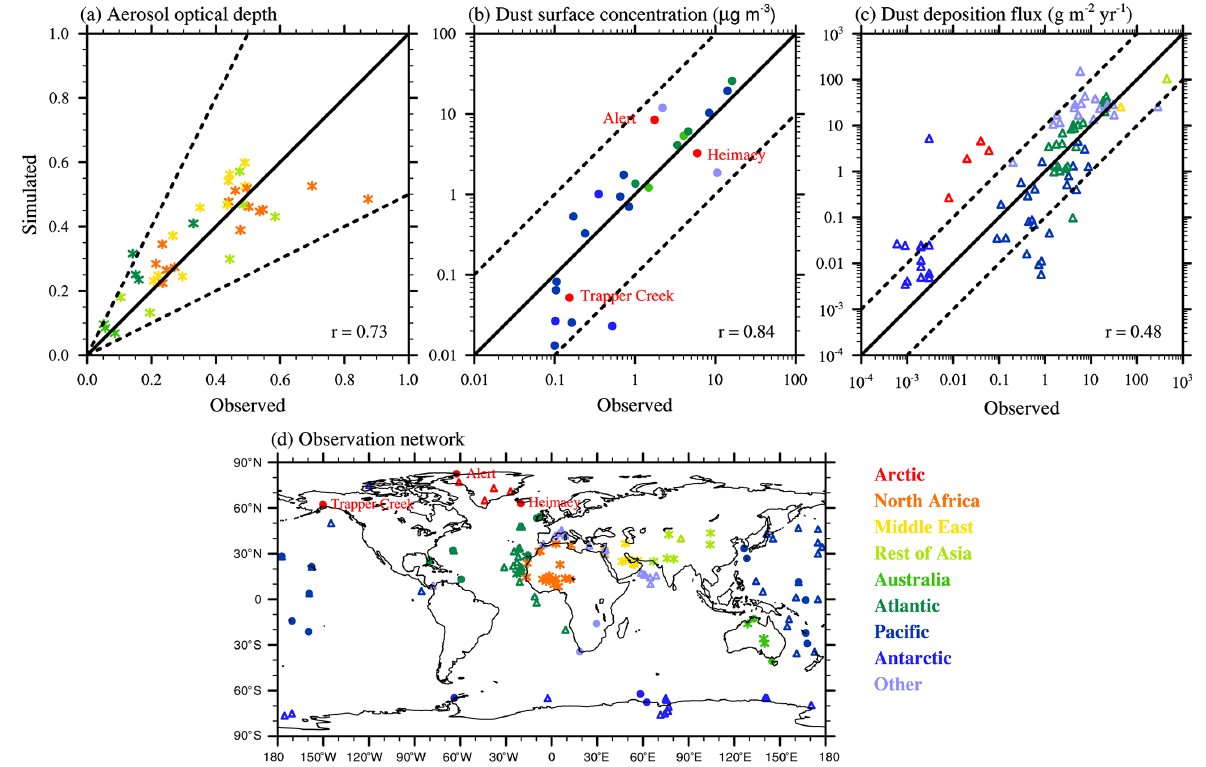
Figure 2. Comparison of observed and simulated (a) averaged AOD at 40 dust-dominated stations (stars), (b) dust surface concentration at 25 sites (circles), and (c) dust deposition flux at 84 sites (triangles). Solid lines represent 1:1 comparison. Dashed lines represent a factor of 2 bias in panel (a) and 1 order of magnitude differences in panels (b) and (c) . For each comparison, the correlation coefficient ( r ) is noted. The AOD data are conducted by AERONET. The dust surface concentration measurements include 20 stations managed by the Rosenstiel School of Marine and Atmospheric Science at the University of Miami (Prospero et al., 1989; Prospero, 1996; Arimoto et al., 1995), two Australia stations (Maenhaut et al., 2000a, b), and three Arctic stations (Heimaey – Prospero et al., 2012, Alert – Sirois and Barrie, 1999, and Trapper Creek – IMPROVE). The deposition flux data are a compilation of measurements from Ginoux et al. (2001), Mahowald et al. (2009), and the Dust Indicators and Records in Terrestrial and Marine Paleoenvironments (DIRTMAP) database (Tegen et al., 2002; Kohfeld and Harrison, 2001). Stations are grouped regionally and classified by different colors. The locations of the measurements are shown in panel (d)